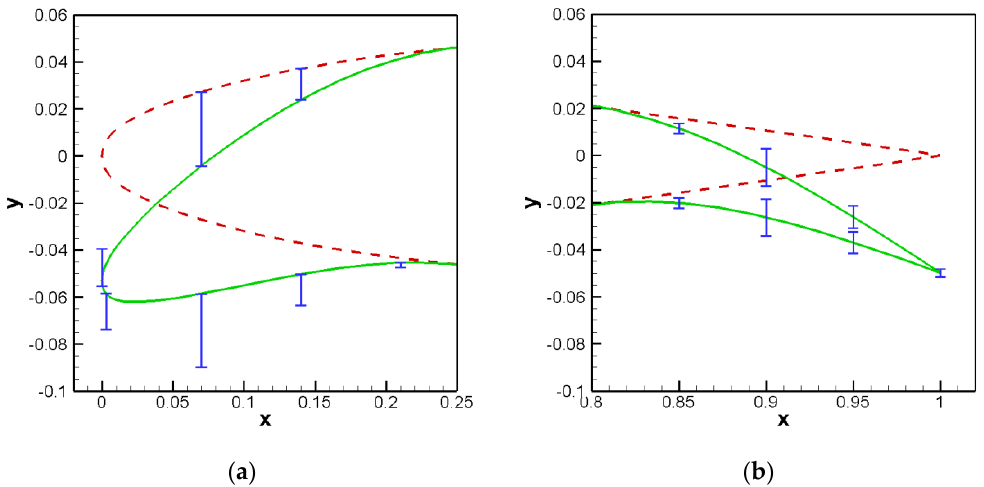
Figure 3. Range of variation of design variables at ( a ) the LE region and ( b ) the TE region (indicated by the blue bar). The initial NACA 64A010 is depicted in red and the airfoil geometry after the reference deformation is depicted in green.